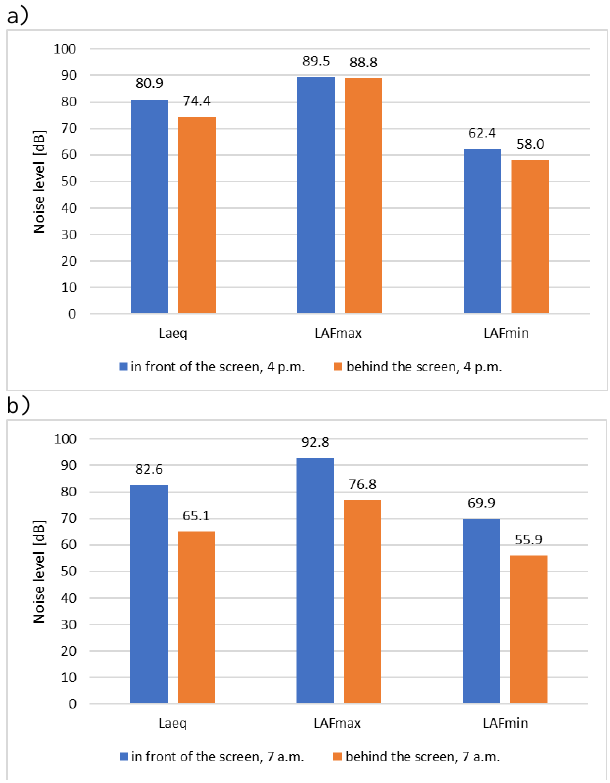
Fig. 2. The impact of vehicle traffic on the noise levels obtained in front of and behind the acoustic screen for the selected measuring section (Wincen- tego Witosa Street, Poznan) during the traffic rush: a) in the afternoon around 4 p.m., b) in the morning around 7 a.m. [20] The use of an acoustic screen at Wincentego Witosa Street allowed to reduce the noise level from 6.5 to